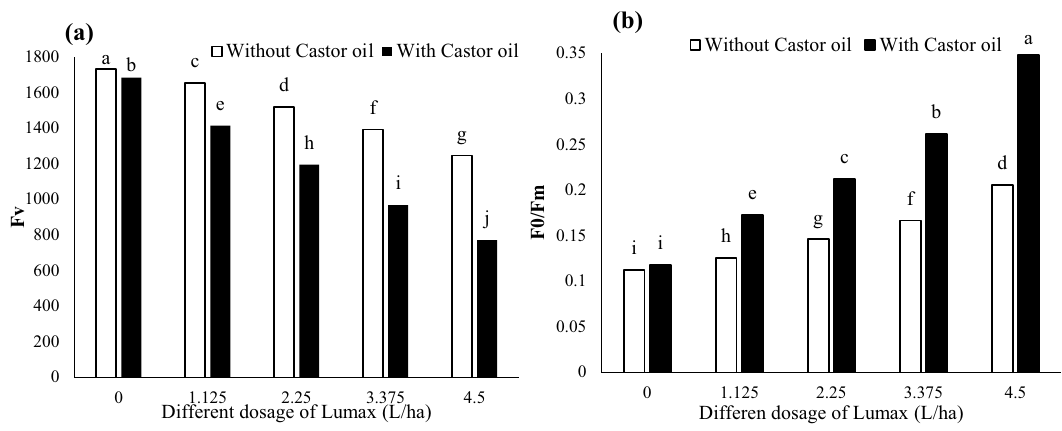
Figure 6. Changes in Fv ( a ) and F0/Fm ( b ) of Solanum gigrum in response to different doses of Mesotrion + S-metolacholor + Terbuthylazine with and without Castor oil. Each value is the mean of four replicates. Different letters represent significant differences ( P <